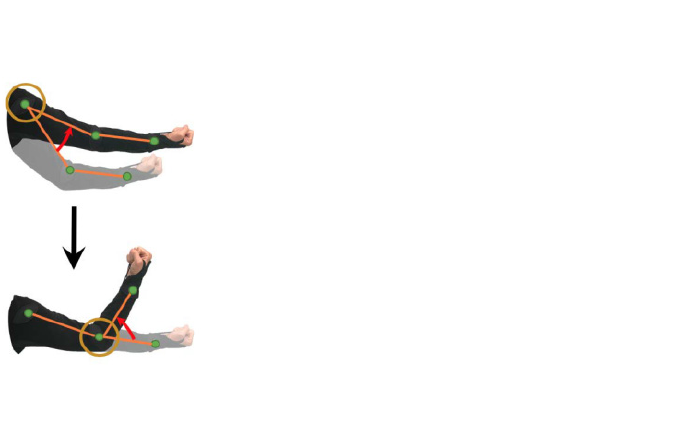
Figure 13. The left picture shows the skeleton tree model proposed in [51], and the right picture shows the joint rotation. The elbow is relative to the shoulder and rotates the hand with respect to the elbow.